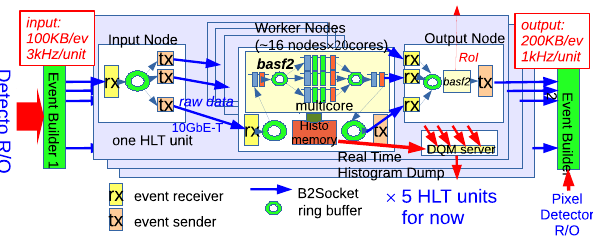
Figure 4. The Belle II High Level Trigger. It is implemented in multiple units of PC farms. One unit consists of one input and output node and up to 16 worker nodes equipped with 20 cores. The data flow between nodes is implemented using a socket connection combined with the ring bu ff ers.